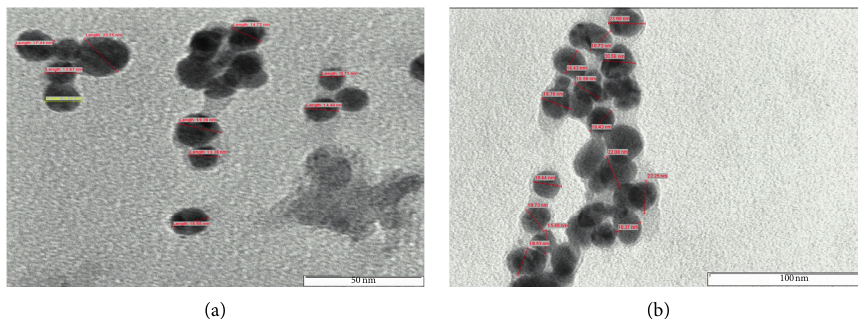
Figure 2: UV-Vis spectra of (a) aqueous and (b) methanolic G. perpensa -mediated AgNPs.